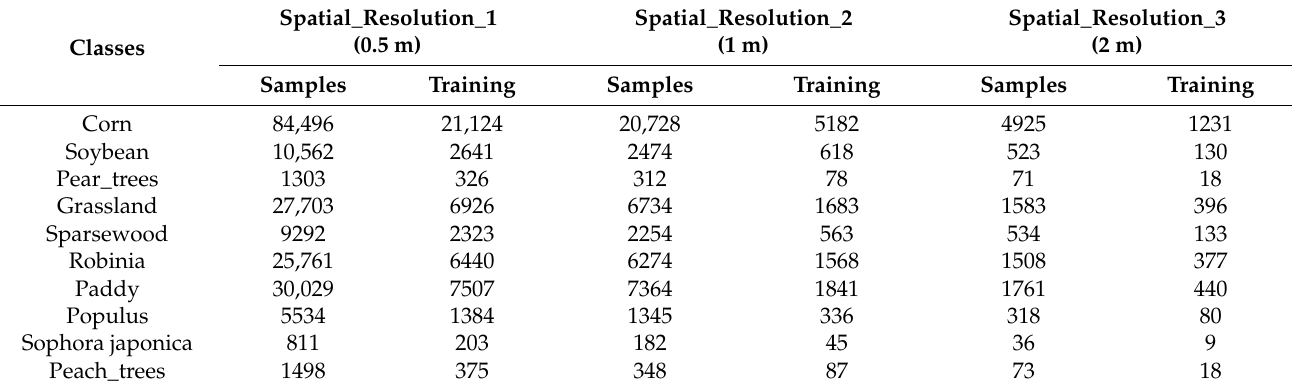
Table 7. Samples and training samples used in Xiong’an dataset with different spatial resolutions.